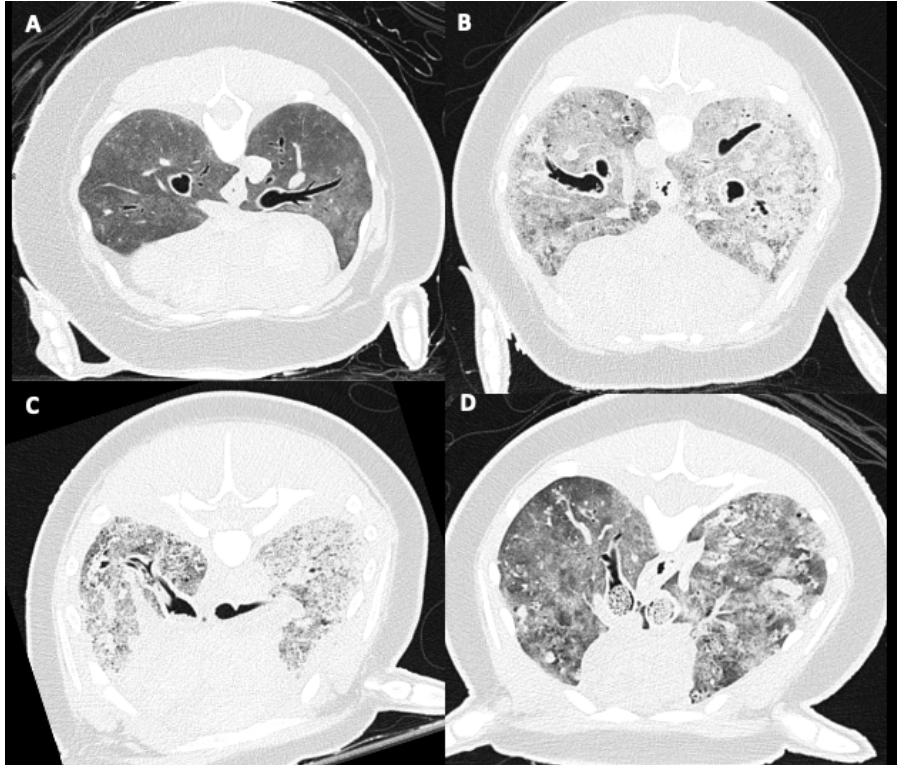
Figure 2. Intraluminal tracheobronchial tubular structures’ severity score on PMCT. ( A ) Absent, ( B ) mild: few parasites present, filling less than 25% of the bronchial lumen, ( C ) moderate: filling 50–75% of the bronchial lumen, and ( D ) severe: parasites present up to the level of the trachea, almost complete occlusion of bronchial lumen.